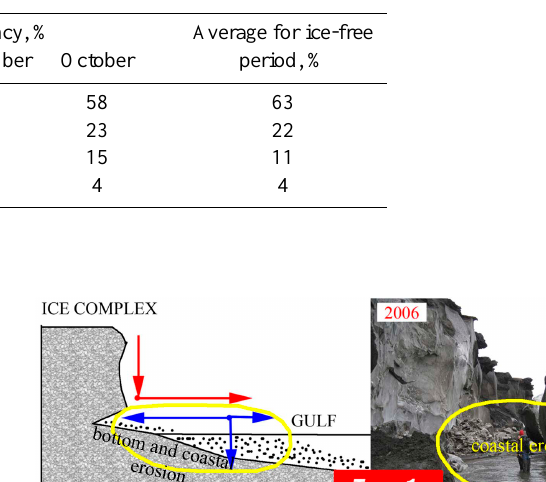
Table 4. The average frequency of wave heights for Buor-Khaya Bay (Navigational book, 1998).